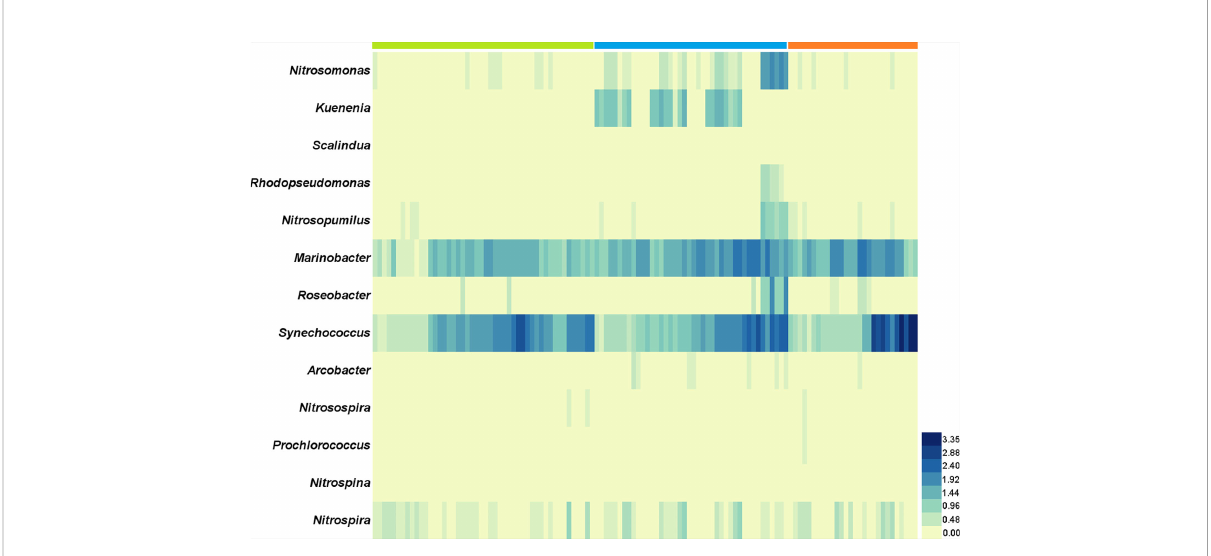
FIGURE 2 The abundance variation of 13 genera of nitrogen-transforming bacteria in the offshore shell fi sh farming waters. The x-axis is samples in chronological order. Green: 2017; blue: 2018; orange: